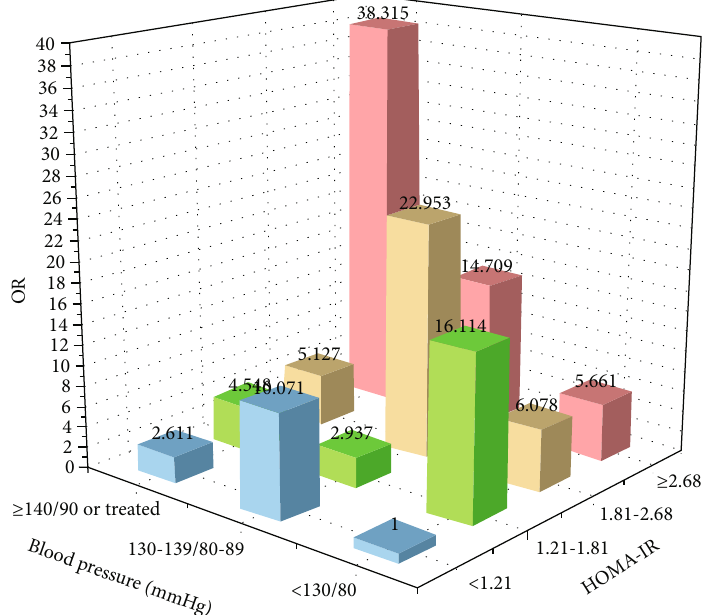
Figure 2: The relationship between HOMA-IR, BP, and new-onset